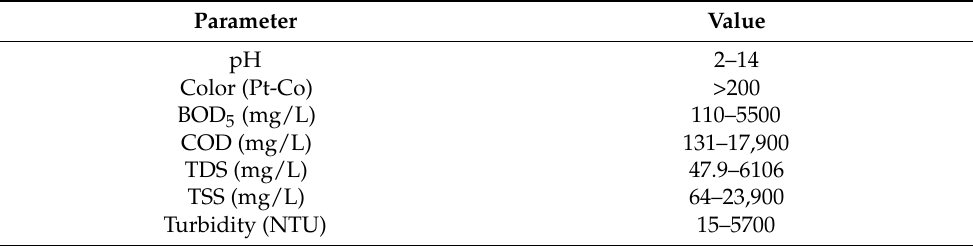
Table 1. Parameters of textile wastewater [1].